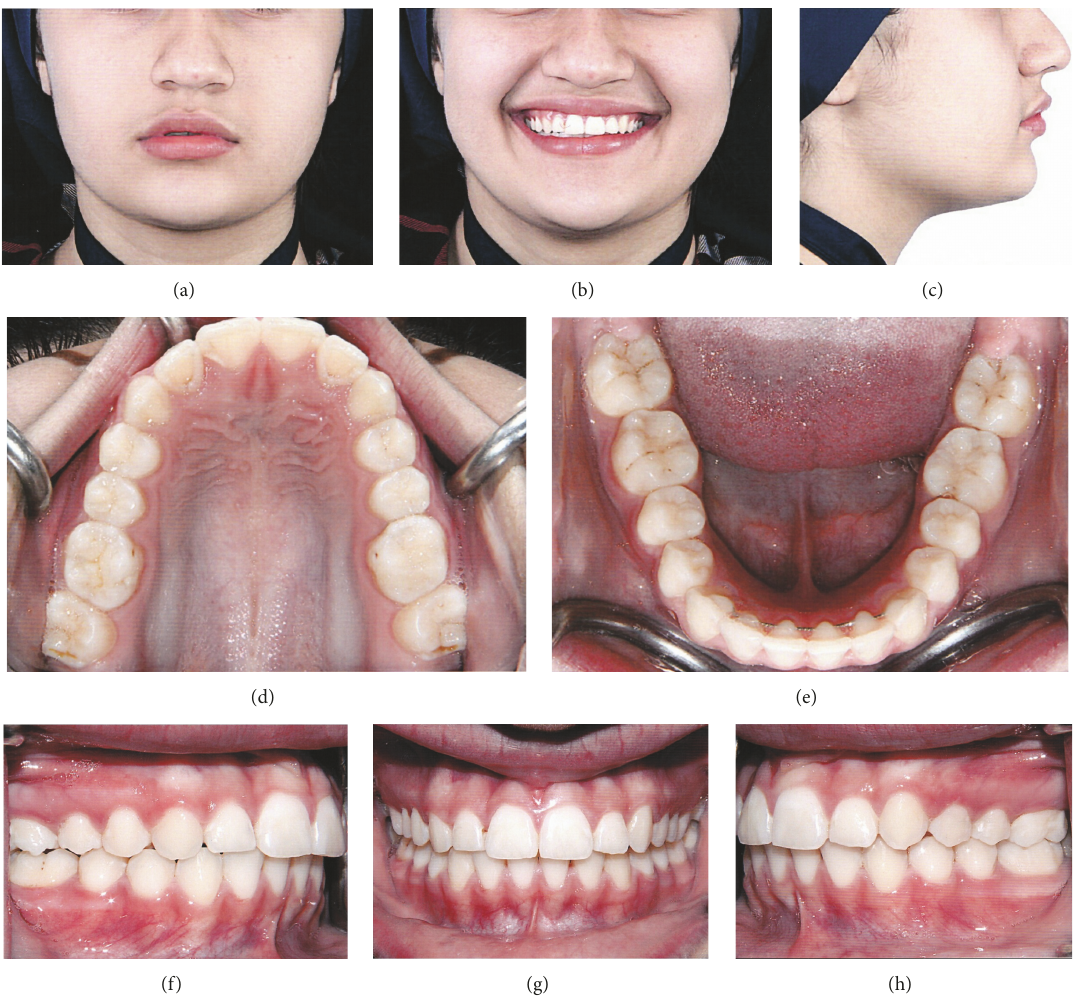
Figure 7: Posttreatment photos: frontal (a); smile frontal (b); profile (c); intraoral views: upper occlusal (d), lower occlusal (e), right (f), frontal (g), and left